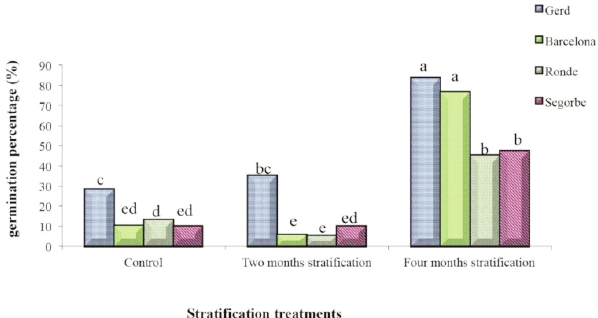
fig. 4 - effect of stratification treatments and cultivar on seed germination percentage of hazelnut cultivars.